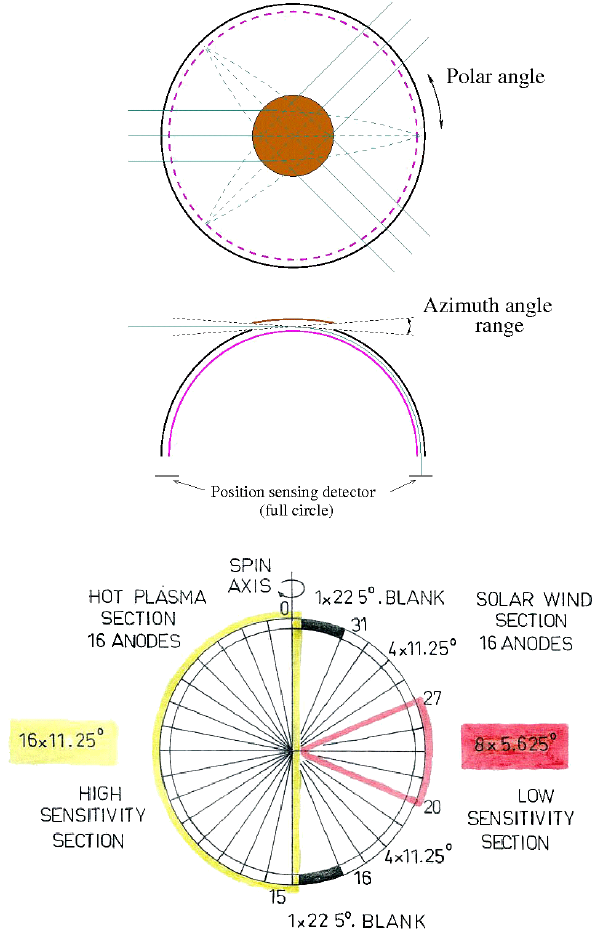
Fig. 1. The upper panels present the top view and cross-sectional view of the HIA instrument. In the bottom panel, the principles of HIA’s anode sectoring are shown. In the upper and bottom panels of the figure, the spin axis is in the plane of the paper, along the vertical direction, while in the middle panel it points into the paper. See text for more details. Figure adapted from Klumpar et al. (2001) and Rème et al.